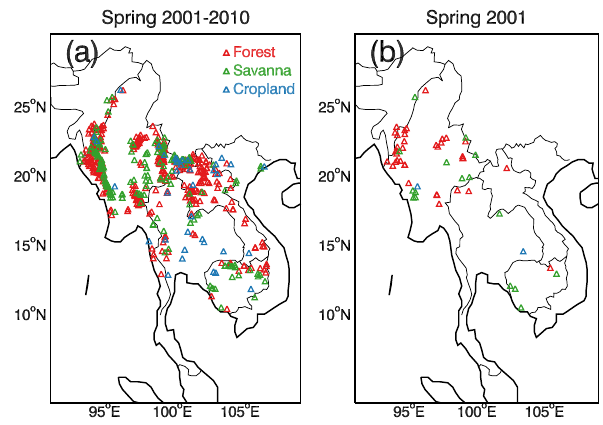
Fig. 1. Locations of identified smoke plumes over PSEA during February–April (a) for the years 2001 to 2010 and (b) for the year 2001. Symbols represent plumes over evergreen and decidu- ous broadleaf forests (red), woody savannas (green), and cropland and cropland/natural vegetation mosaics (blue).